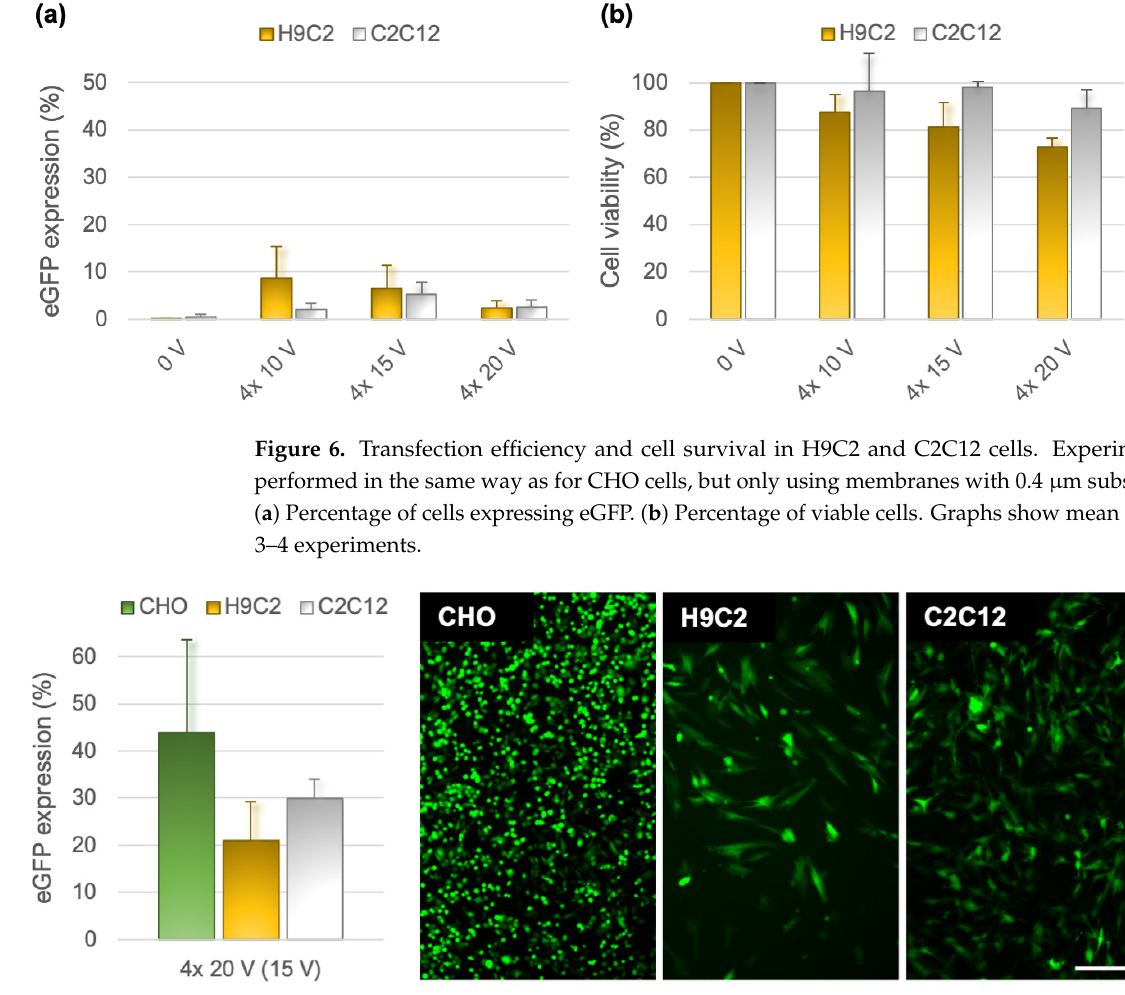
Figure 7. eGFP expression in CHO, H9C2, and C2C12 cell lines using higher plasmid concentration of 500 µg/mL. Transfection was performed with four 10-ms-long pulses with optimized voltages of 20 V (CHO) and 15 V (H9C2 and C2C12). Graph shows mean ± s.d. from 3–4 experiments. The fluorescence images visualize the corresponding eGFP expression in each cell line. Scalebar: 200 µ m, same for all three